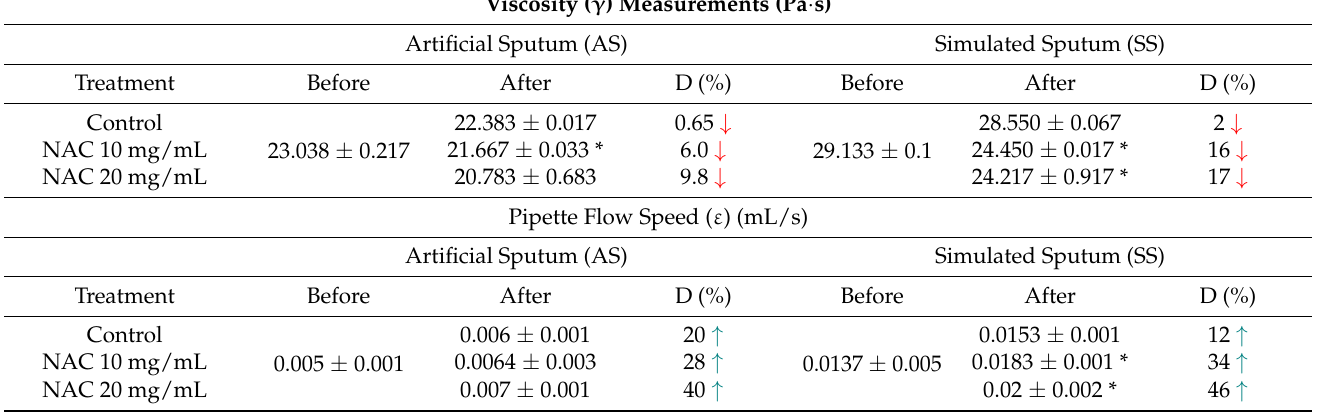
Table 2. The effect of aerosolized N-Acetylcysteine on both artificial and simulated sputa using two parametric measurements such as viscosity and pipette flow time. NAC: N-Acetylcysteine. Data presented as mean ± SD. Test samples were compared with control after treatment for significance testing; *: p < 0.05; ↓ = decrease; ↑ =